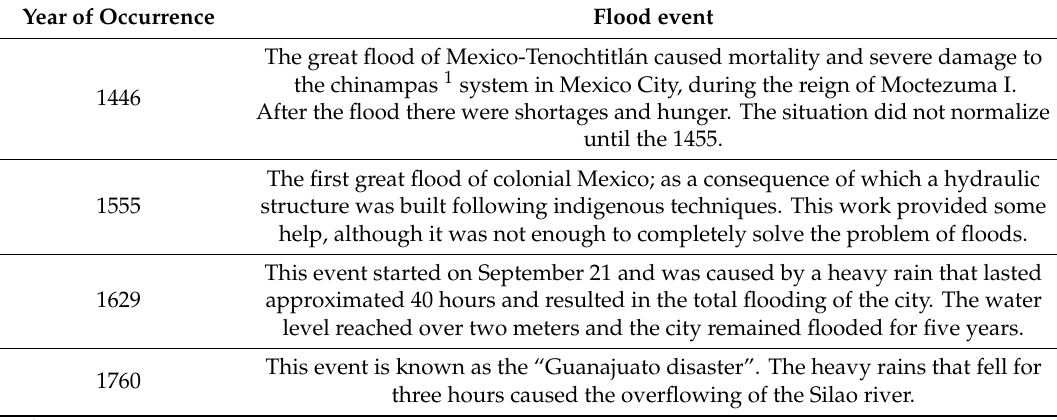
Table 1. Historically documented major floods occurred in Mexico (modified after Arregu í n-Cort é s and Cervantes-Jaimes